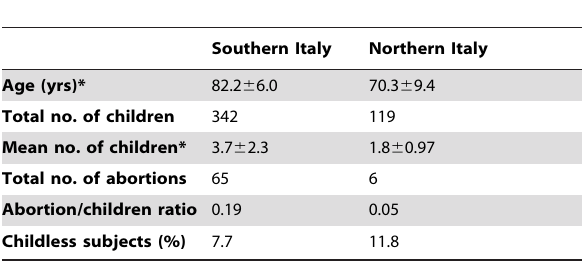
Table 1. Characteristics of the two study